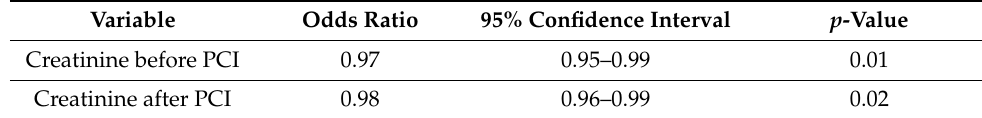
Table 8. Predictors of stent expansion—logistic regression analysis.